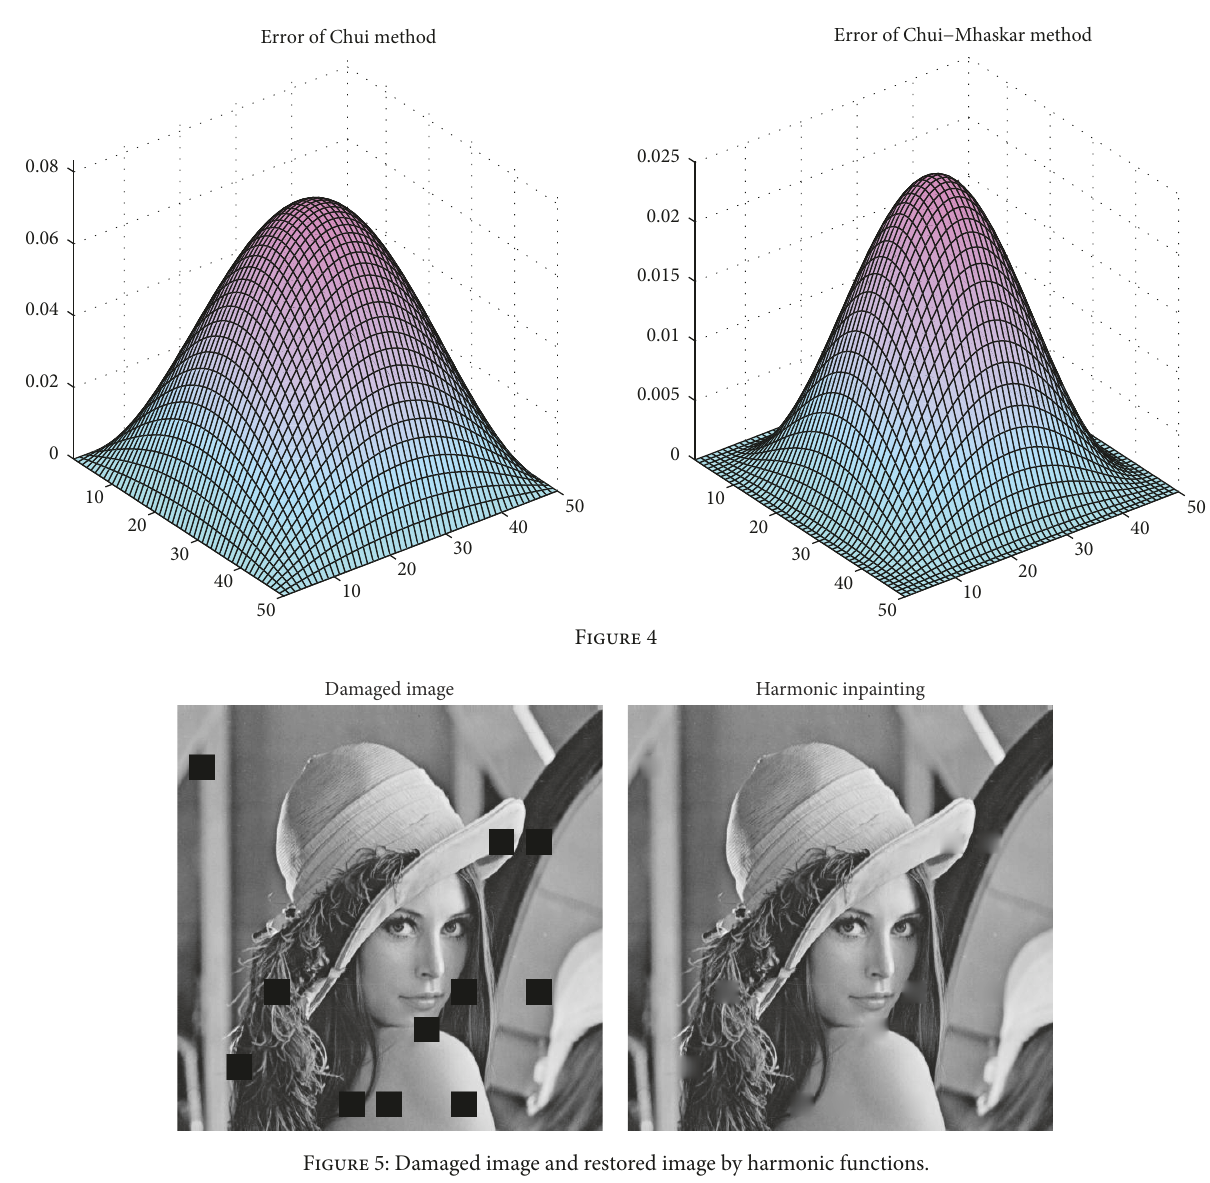
Figure 5: Damaged image and restored image by harmonic functions.